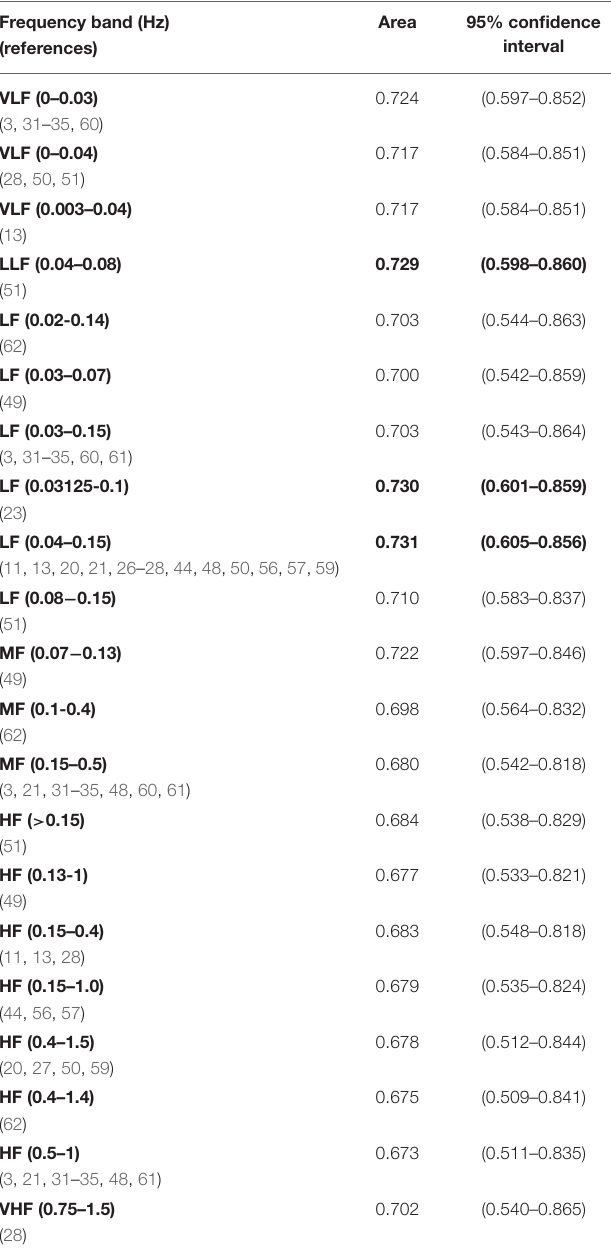
TABLE 4 | Areas under ROC curves and correspondent non-parametric confidence interval, for the bands significantly different between groups of fetal